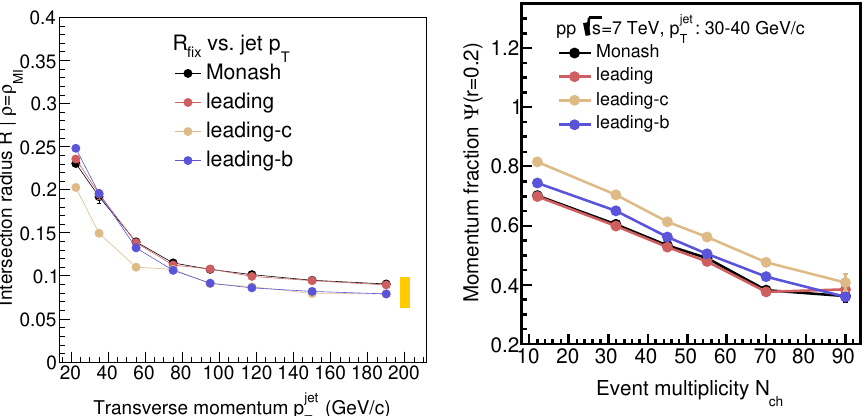
Figure 3. ( Left ) The p jet dependence of R fix for heavy flavors. ( Right ) The integral jet structure at T r = 2 for heavy